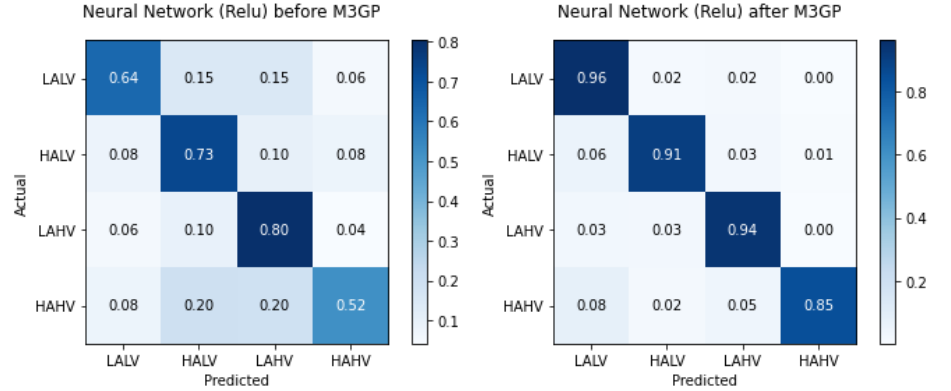
Figure 10. Classification results with ReLU: on the left-hand side is the classification without treatment; on the right-hand side is the classification with the M3GP transformation.